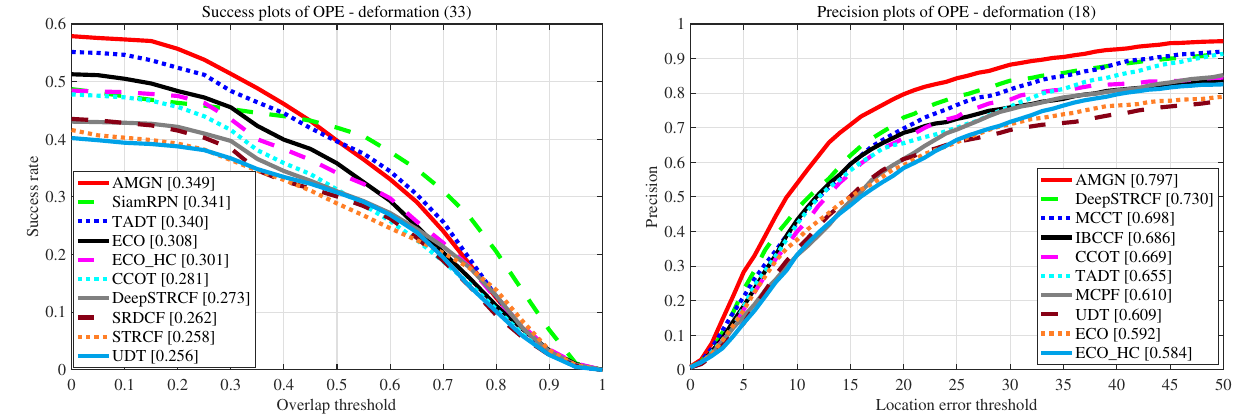
Figure 8. Success and precision plots on the DTB70 dataset using one-pass evaluation over tracking challenge Deformation.